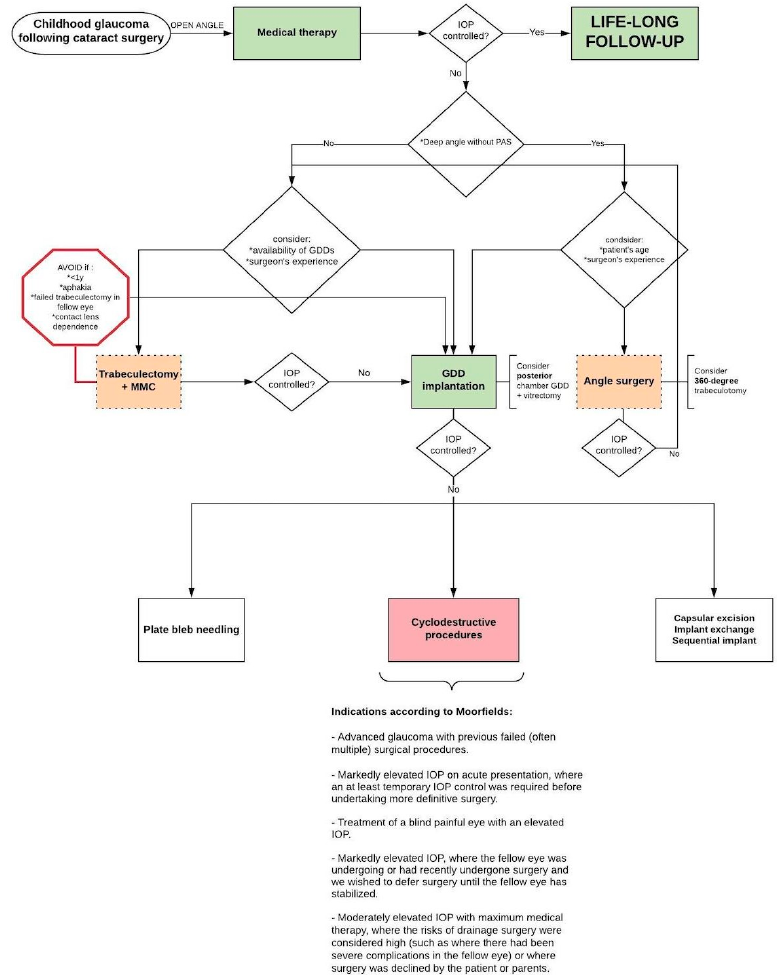
Figure 3. Suggested flowchart for the management of childhood GFCS with open-angle configuration (adapted with permission from Grigg, World Glaucoma Association Consensus Series 9: Childhood glaucoma, Kugler publications 2013 [16]). Abbreviations: IOP = Intra-Ocular Pressure; MMC = Mitomycin C; y = years; GDD = Glaucoma drainage device; PAS = peripheral anterior synechiae.